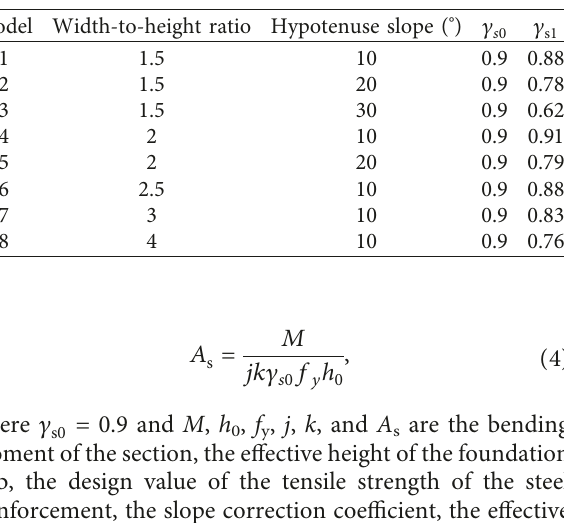
Figure 14: Typical stress distribution of concrete in the most dangerous section. (a) Partial plasticity. (b) Development of plasticity. (c) Whole section plasticity. Table 7: Comparison of the coefficients of the internal force